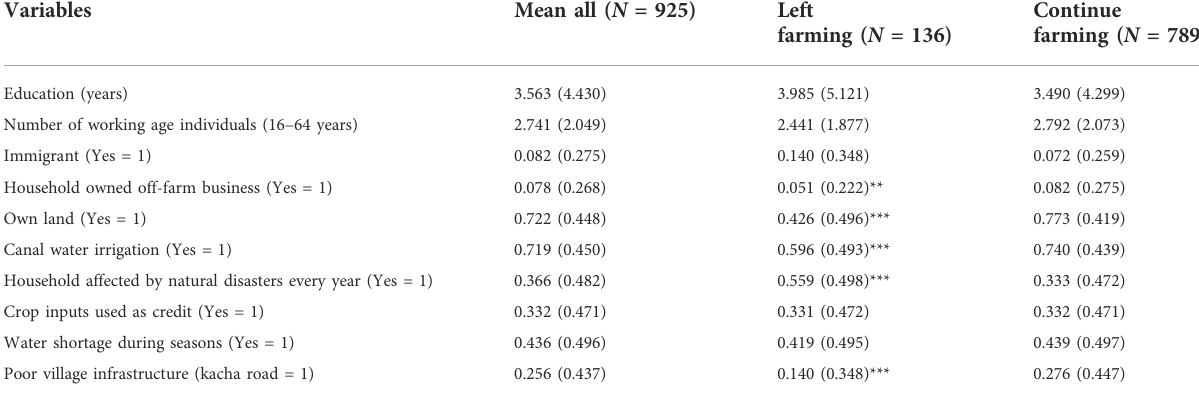
TABLE 4 Variables, de fi nitions, means, and difference-in-means tests.